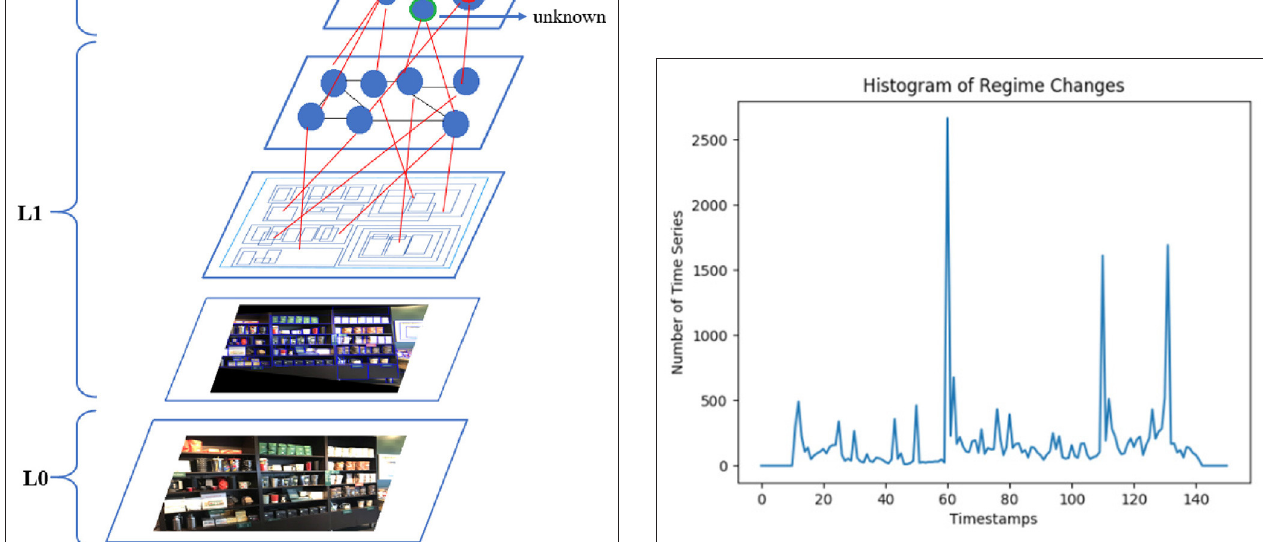
TABLE 1 | Experimental results from retail use case using metamodel. Without FoA (%) With FoA (%) Category Precision Recall f1-score